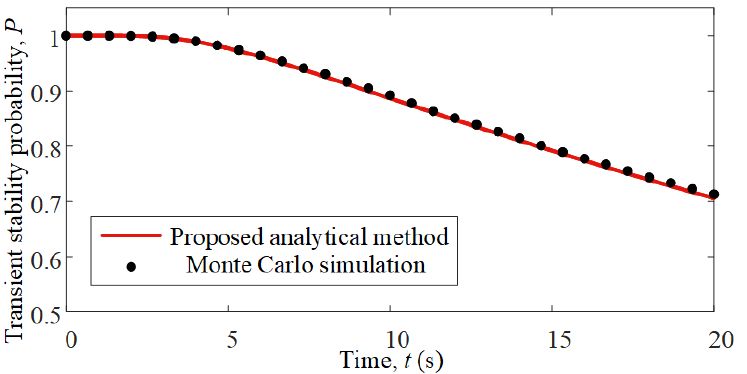
Figure 4. Stability probability of power system with losses under stochastic continuous disturbances.